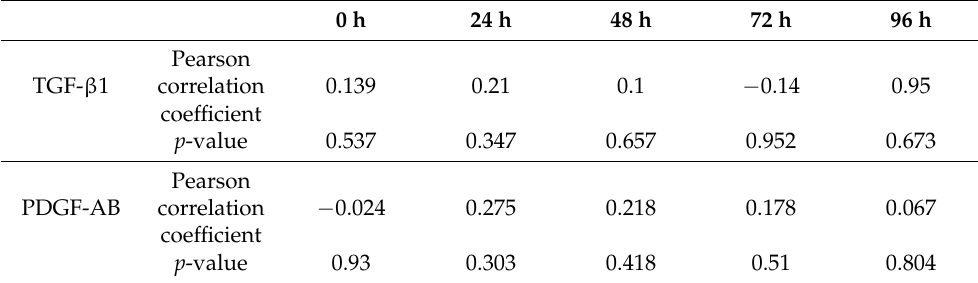
Table 3. The correlation between the concentration of platelets and cytokines at different time